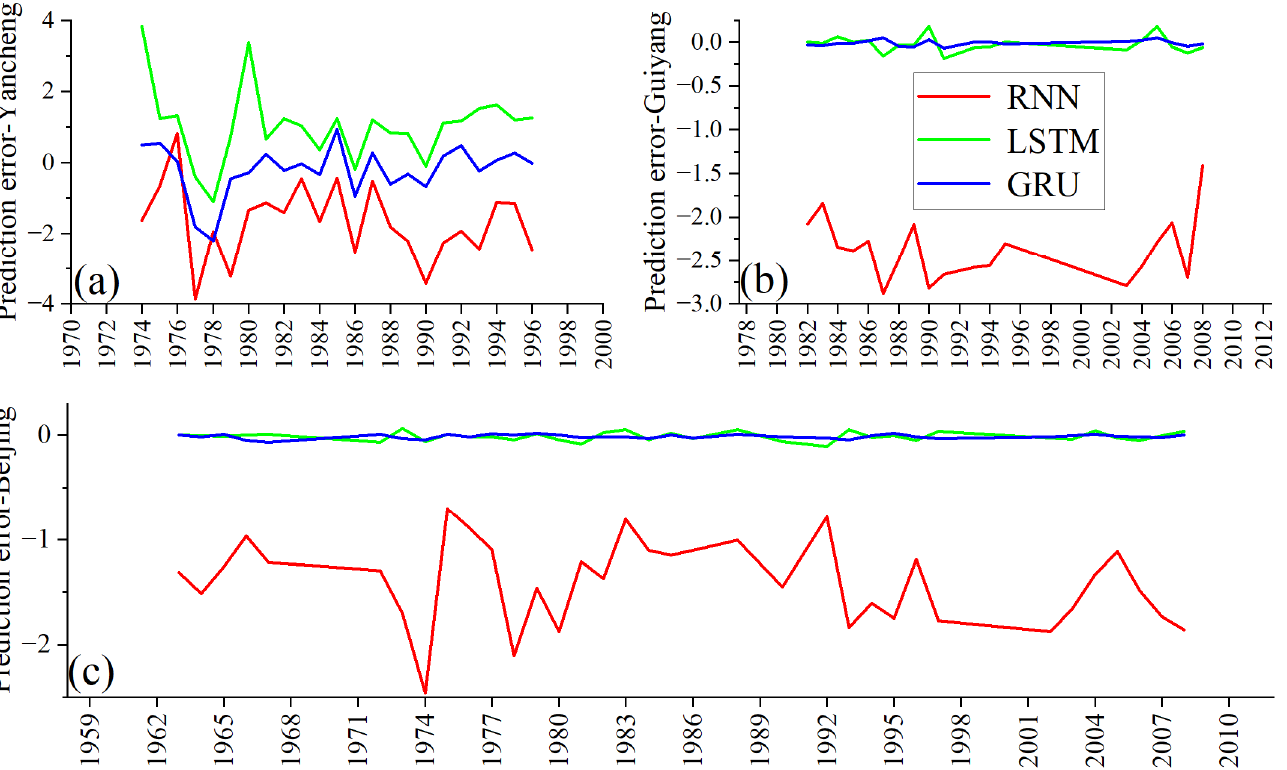
Figure 5. Interannual variation figure of prediction error of ( a ) Yancheng city, ( b ) Guiyang city, and ( c ) Beijing city. ( c ) Beijing